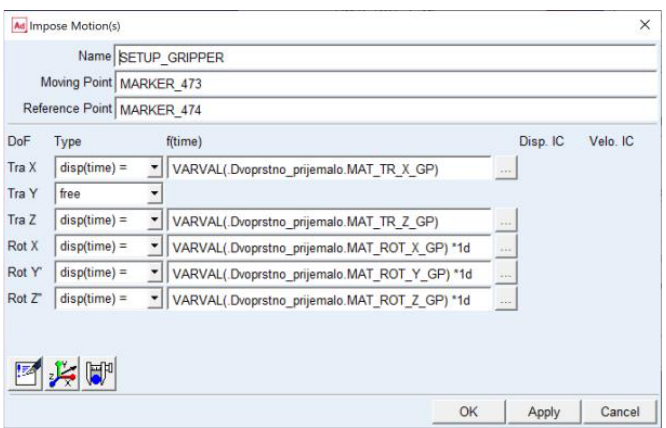
Figure 5. Translation and rotation settings of the robotic gripper in ADAMS/View. Source: own. Table 1. Model contact parameters. Source: